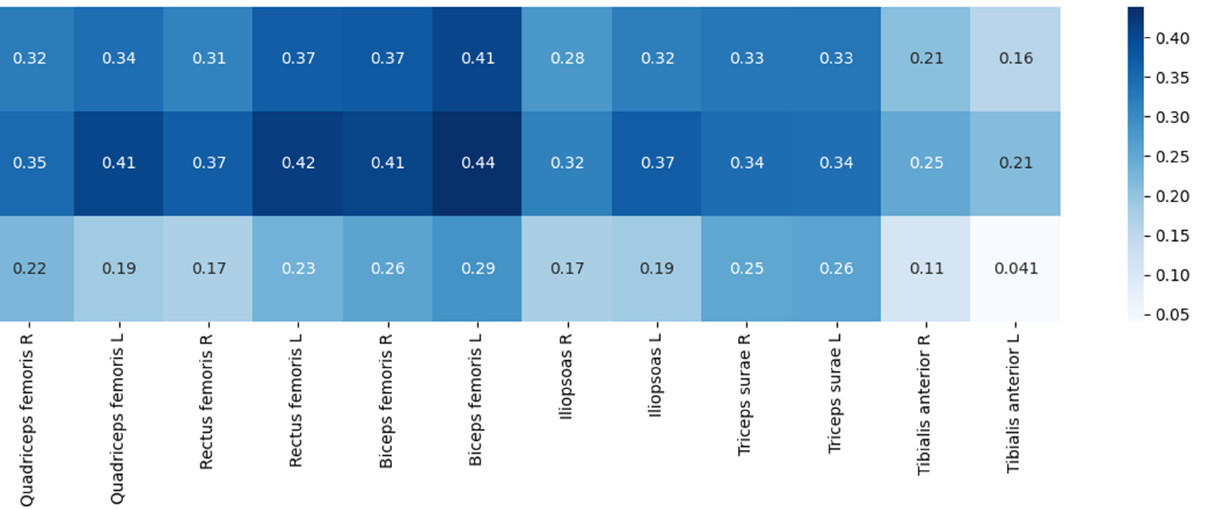
Figure 2. Correlation matrix visualizing correlations between SF-36 scores and muscle strength (Pearson’s test). Positive correlations are visualized in shades of blue, and negative correlations are visualized in shades of red. Statistically significant correlations are marked with an asterisk.